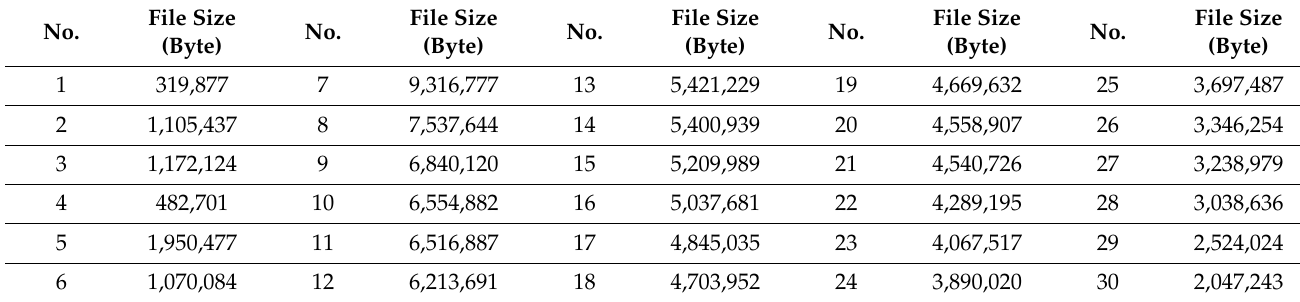
Table 7. Digital Tachograph data file.